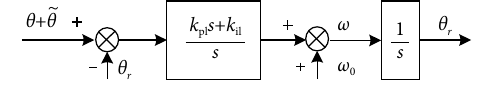
Fig. 4 Control loop of the SRF–PLL.